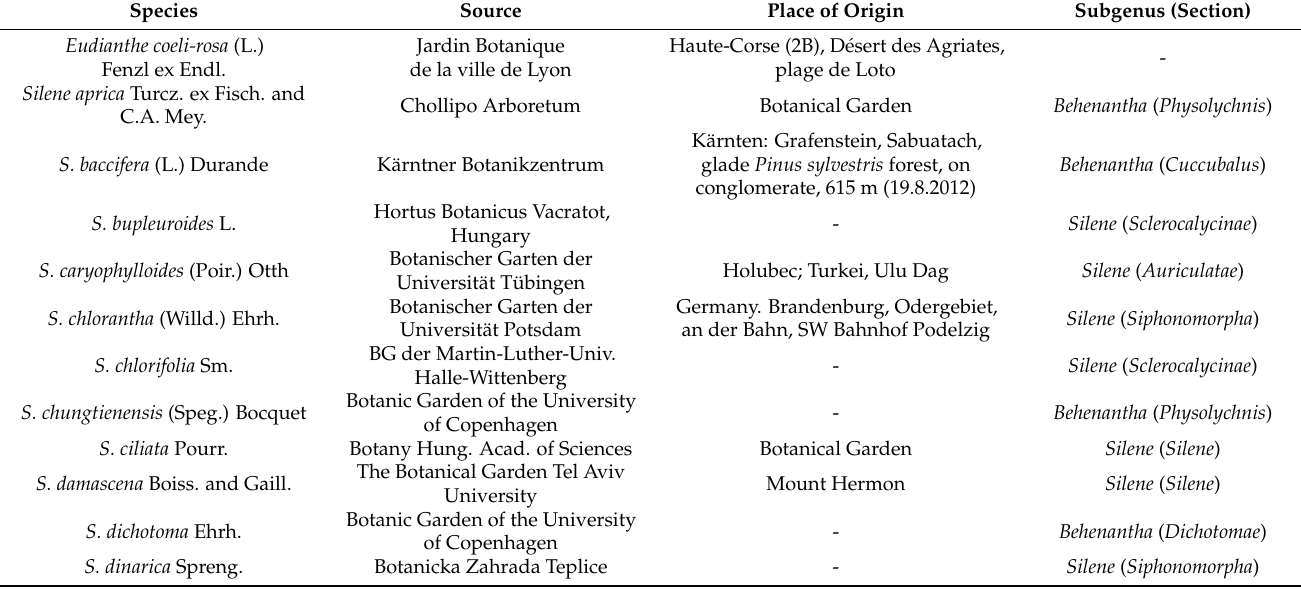
Table A1. Seeds of the genera Eudianthe and Silene used in this work, with the indication of the source and origin of the samples, based on the information given from the seed collection of the botanical garden of the University of Valencia (Spain). The name of the subgenus and the corresponding sections (between brackets) are